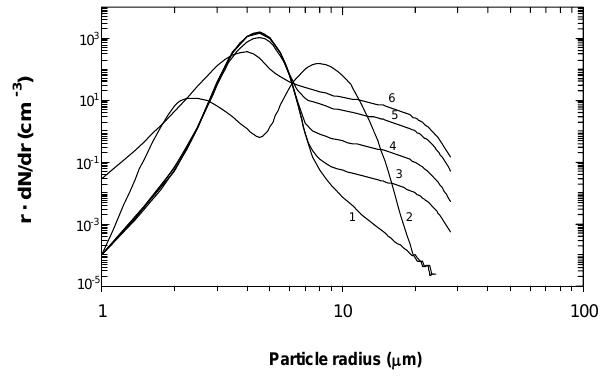
Figure 9. Simulated drop spectrum in the background cloud (1), at the introduction of salt particles with the radius of 1 µm with the mass concentrations of 1.1 mg/m 3 (2) and at the introduction of salt powder with the mass concentrations of 0.01, 0.1, 1 and 5 mg/m 3 (curves 3 – 6, correspondingly).